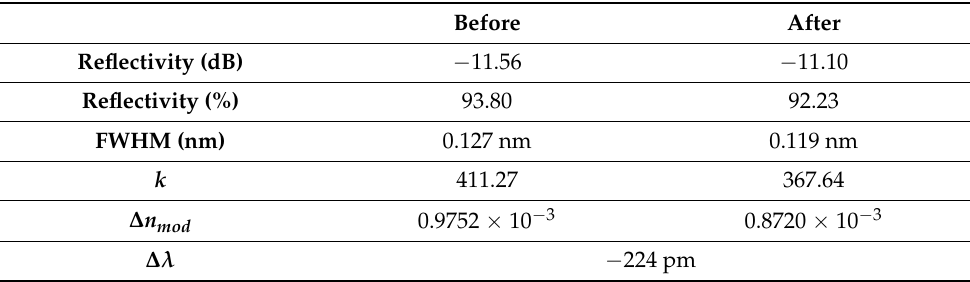
Table 3. Spectral characteristics of the PbP -FBG before and after exposure to electron radiation. Before After